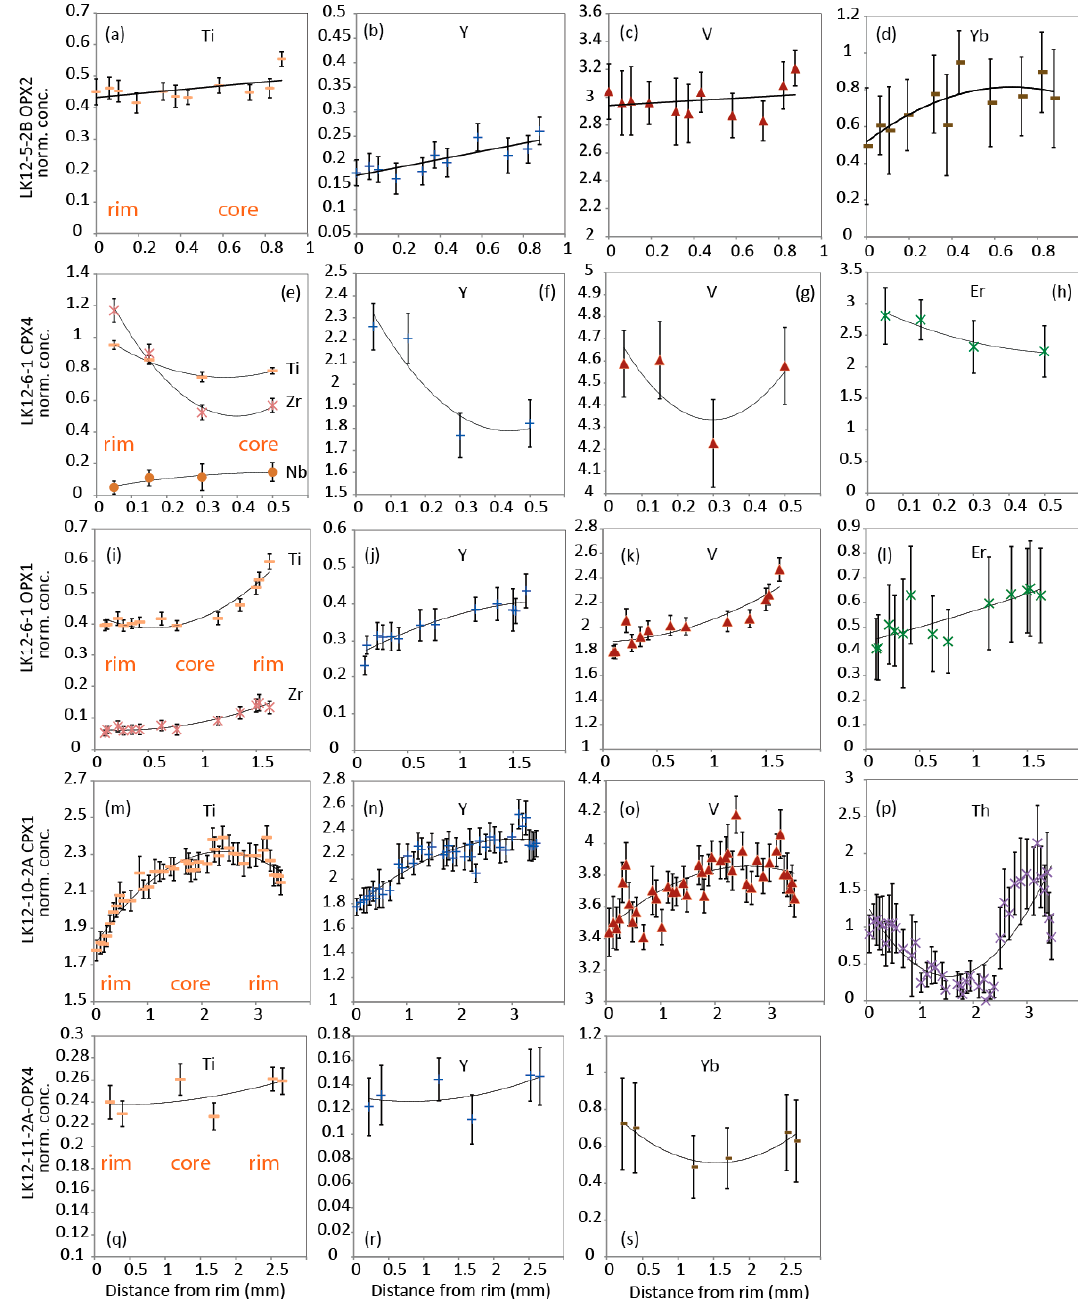
Figure 7. Chondrite-normalized [42] concentrations of selected trace elements in OPX or CPX grains in orthopyroxenite LK12-5-2B ( a – d ), clinopyroxenite LK12-6-1 ( e – l ), clinopyroxenite LK12-10-2A ( m – p ), and in orthopyroxenite LK12-11-2A ( q – s ). Note that LK12-5-2B is a ¾ profile, LK12-6-1 is a ½ profile, and all others are full rim-to-rim profiles. Trend lines are polynomial fits and error bars represent 2SE for each element.